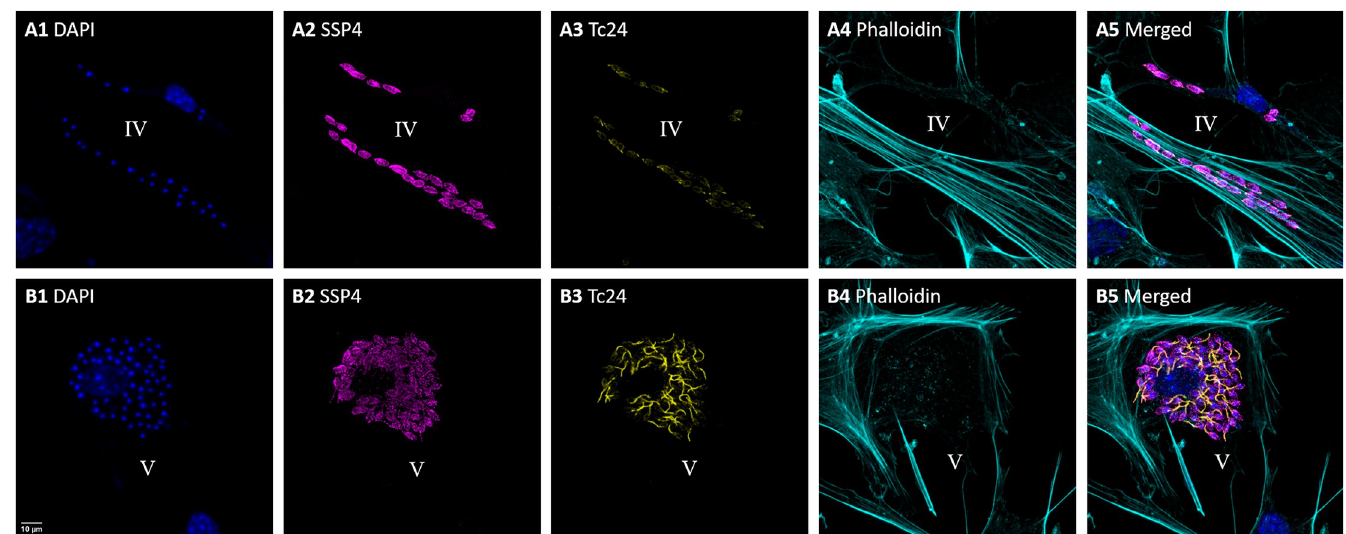
Fig 6. Fluorescence confocal microscopy images of mouse primary cardio fibroblasts infected with T . cruzi show the return of Tc24 expression. Two images were acquired that represent different stages of infection. In A1-A5 two infected cardiac fibroblasts can be seen with only approximately 20 and 6 amastigotes inside, representing stage IV: amastigotes with several (2–4) divisions. In B1-B5 an infected cardiac fibroblast can be seen hosting 60 amastigotes inside, which represents stage V: transformation from amastigote back to trypomastigote. 1) In blue, DAPI nuclear stain. 2) In magenta, detection of the amastigote specific protein SSP-4 using a specific IgG1 antibody followed by staining with anti-IgG1 Alexa Fluor 488. 3) In yellow, detection of Tc24 using biotinylated Tc24-C4/884 followed by straining with streptavidin–Alexa Fluor 555. 4) In cyan, filamentous actin stained with Phalloidin iFluor 647. 5) Merged image of 1–4. Pixel size of images: 120 nm x 120 nm.